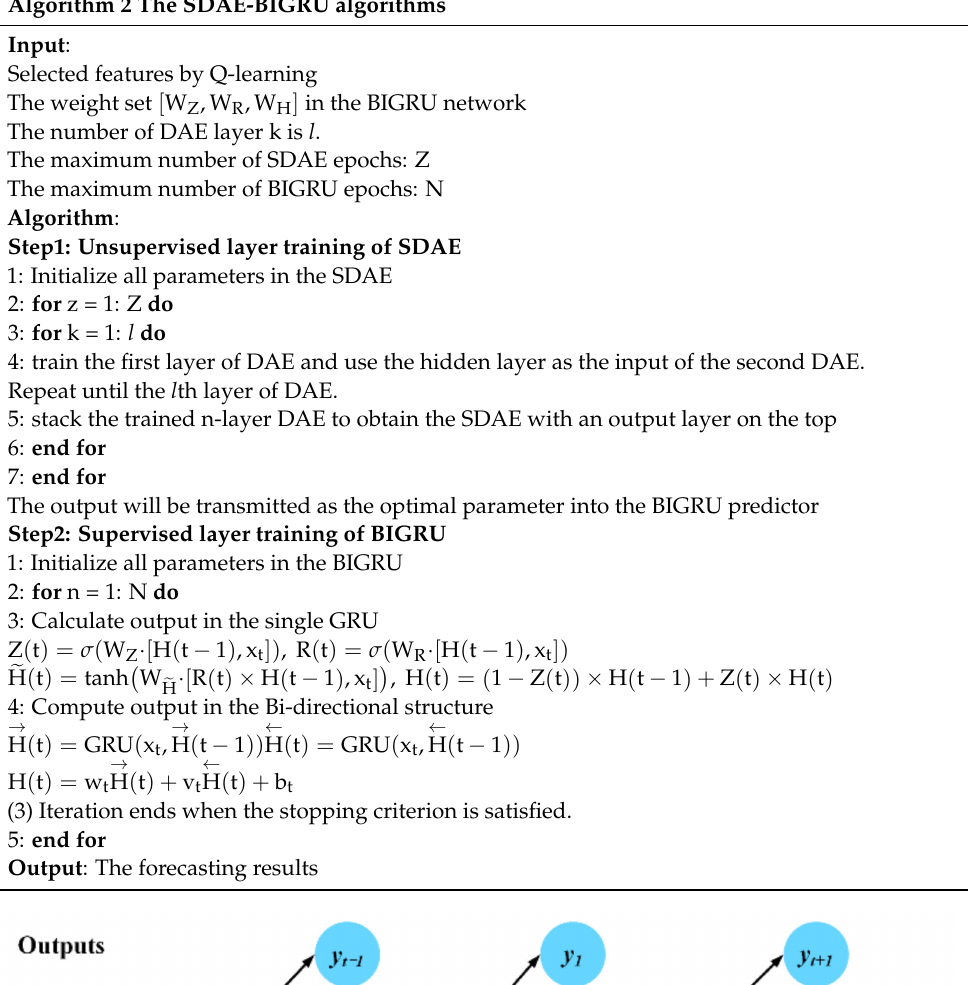
Algorithm 2 The SDAE-BIGRU algorithms